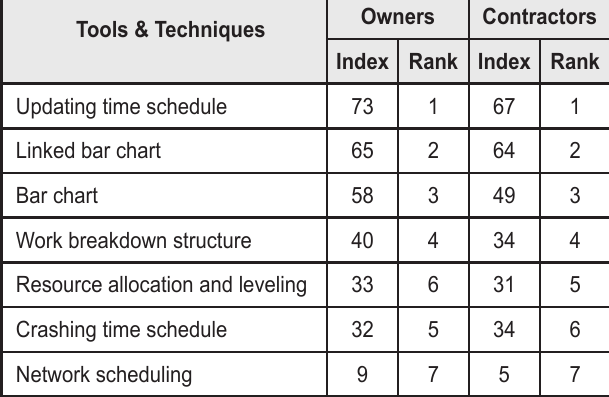
Table 3: Ranking for using time management tools and techniques